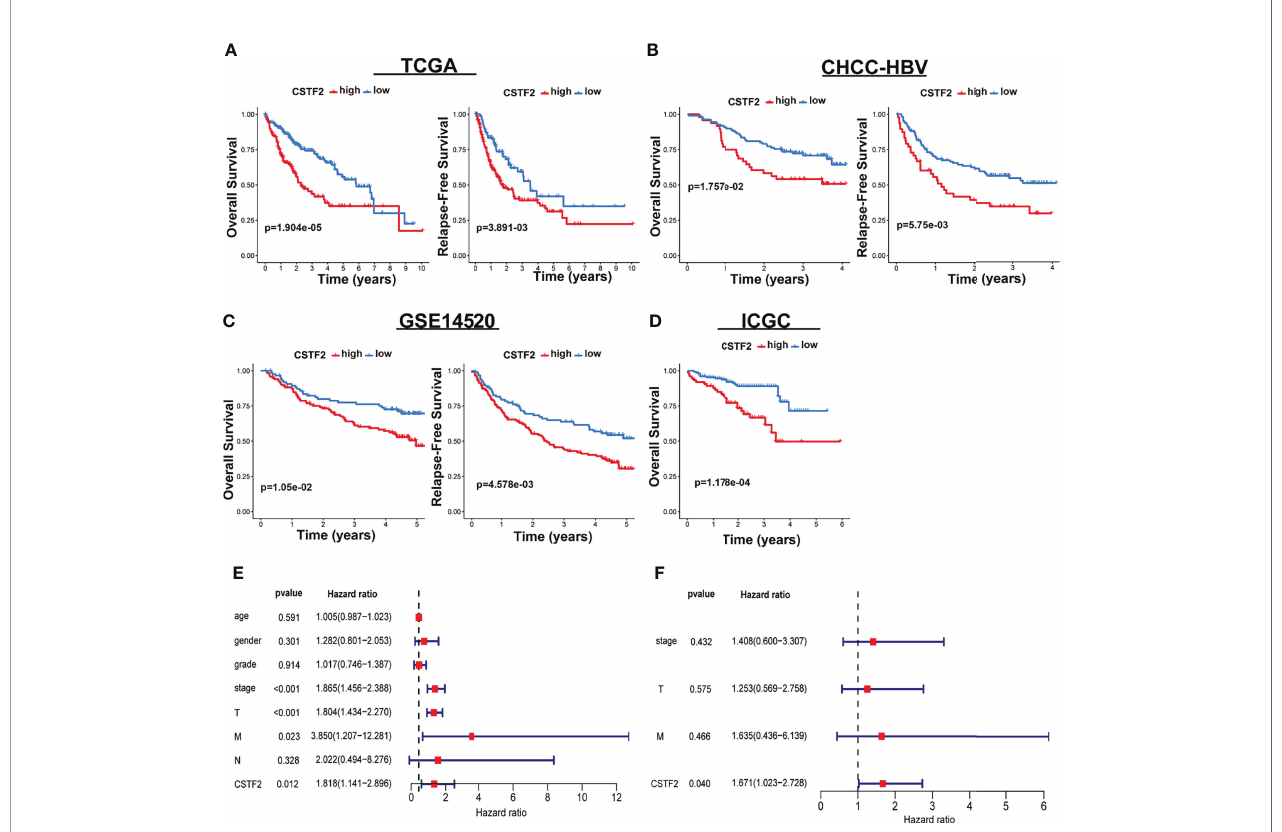
FIGURE 4 | CSTF2 higher expression is associated with poor prognosis in HCC. (A-D) Overall survival and relapse-free survival in TCGA-LIHC, CHCC-HBV, GSE14520, and ICGC databases (E) Univariate and (F) multivariate Cox analyses of CSTF2 expression at different TNM stages, ages, and